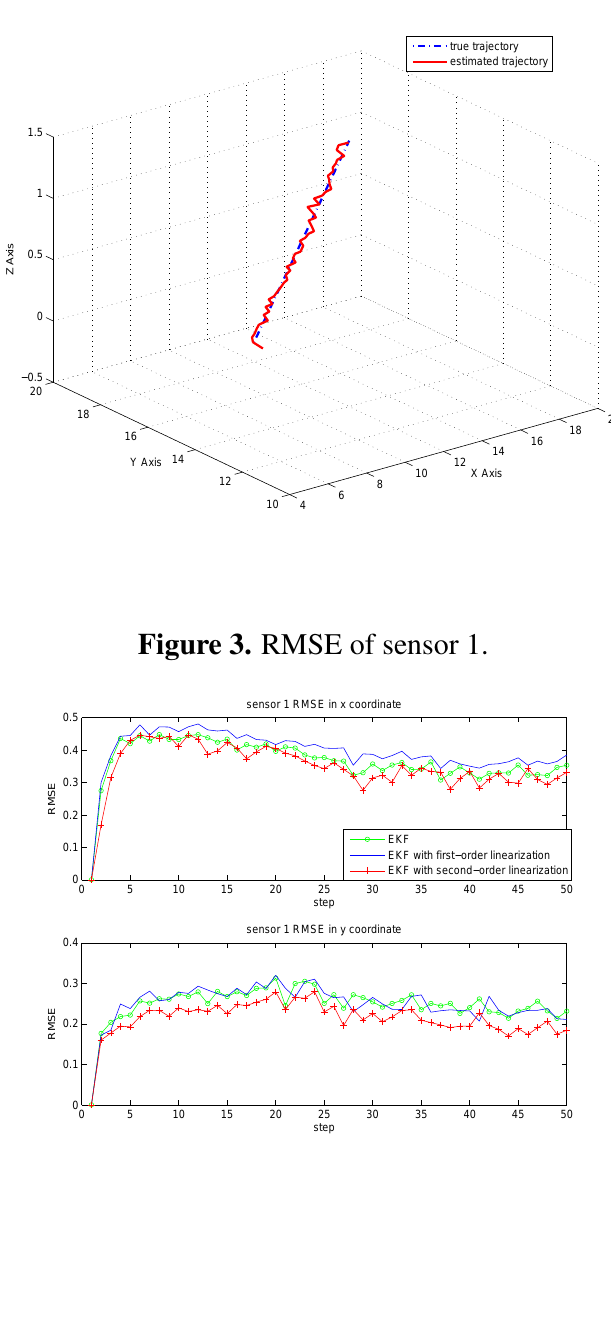
Figure 2. Estimation result of EKF.